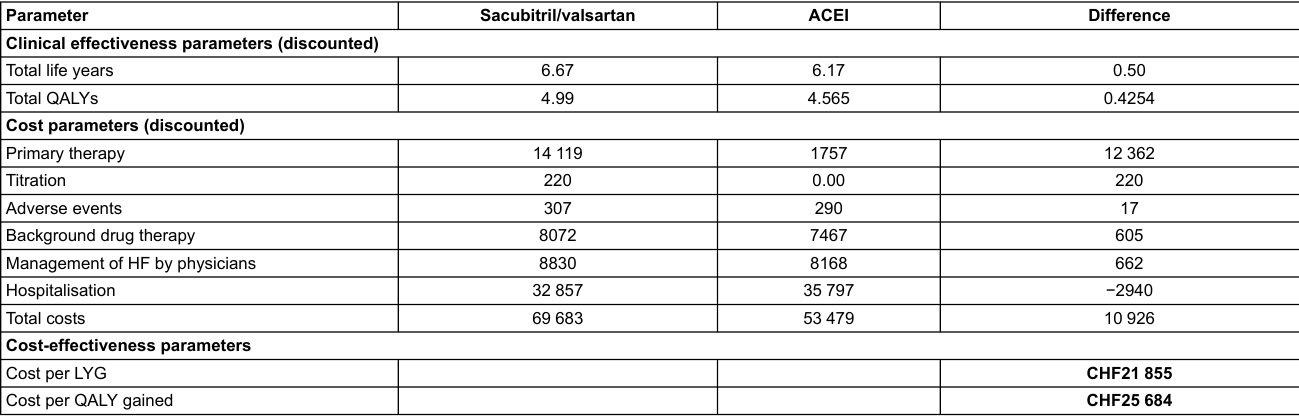
Table 1: Base case results (all costs are expressed in CHF).